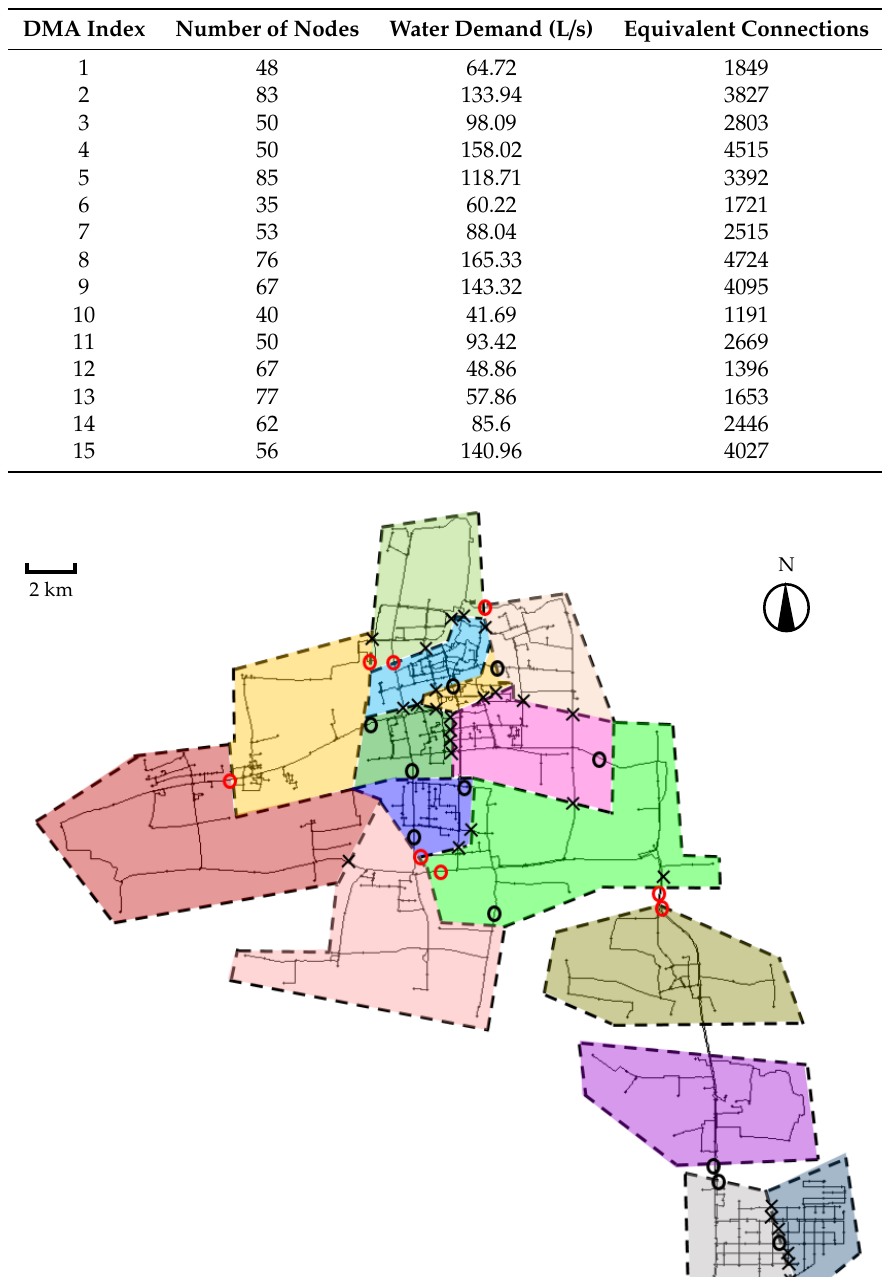
Table 3. Characteristics of H town’s DMAs.